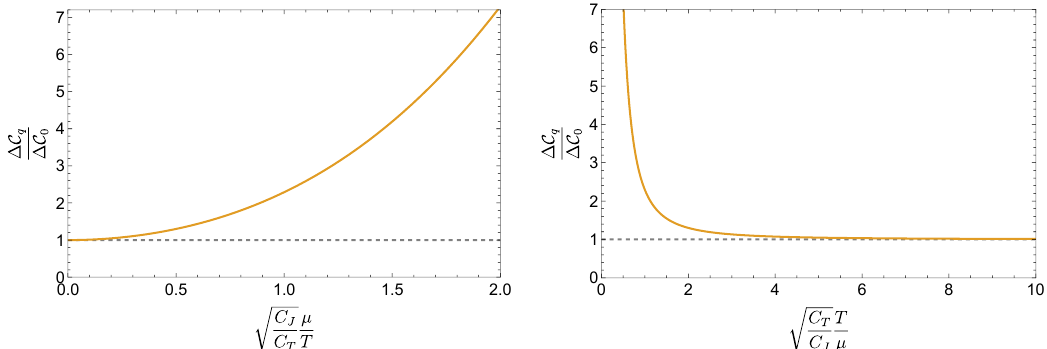
Figure 29 . Complexity of formation from the CV conjecture normalized by (cid:1) C 0 for planar ( k = 0) charged black holes in d = 4 as a function of the dimensionless ratio of boundary quantities (cid:23) (cid:17) q (cid:22) C J and its inverse. Extremal black holes ( T = 0) have divergent complexity of formation also C T T using the CV